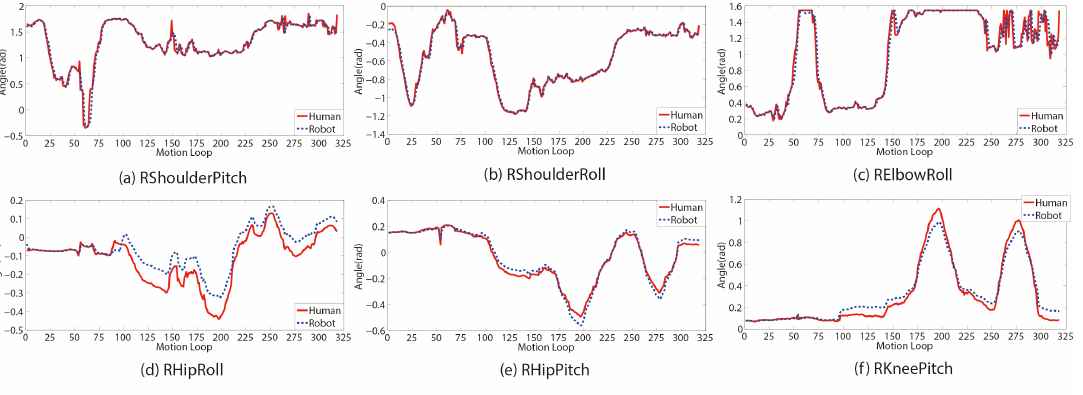
Figure 12. Right key joint angle trajectories of the human and the robot in the first experiment. ( a )–( f ) depict the joint angle trajectories of RShoulderPitch, RShoulderRoll, RElbowRoll, RHipRoll, RHipPitch and RKneePitch,